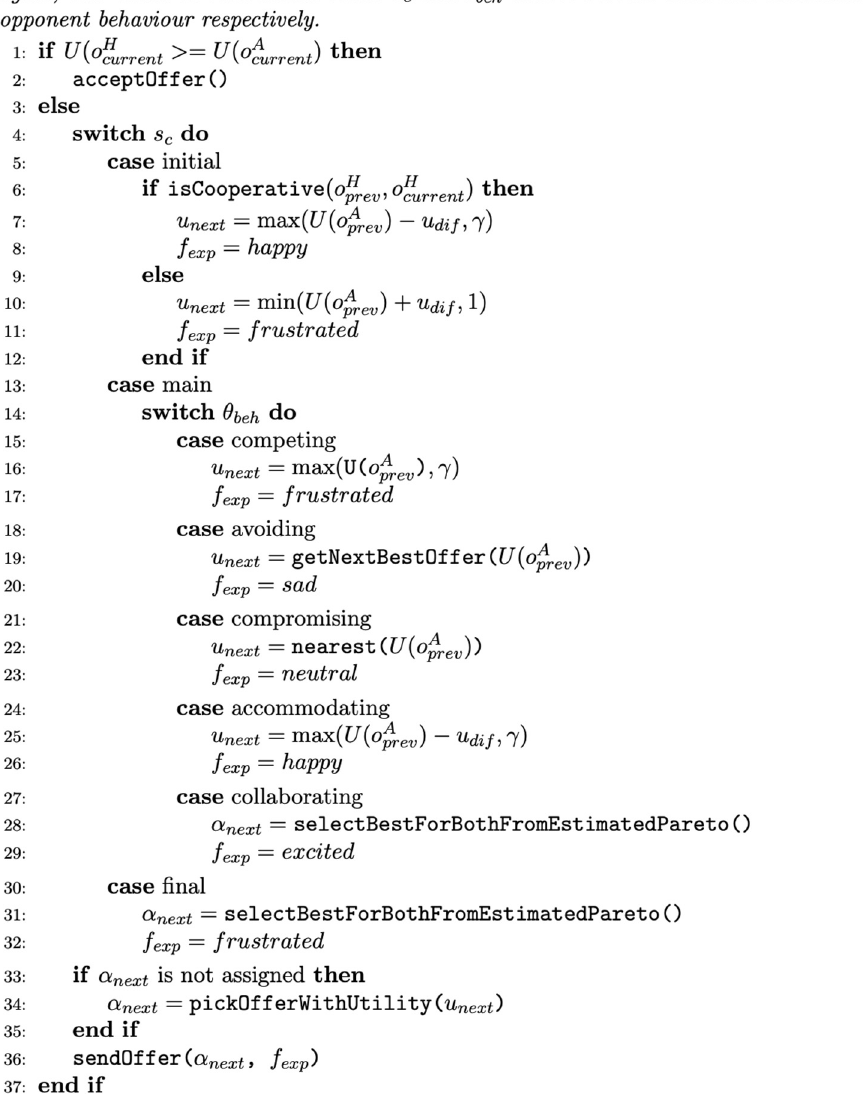
Figure 3. Offer Generation Algorithm.